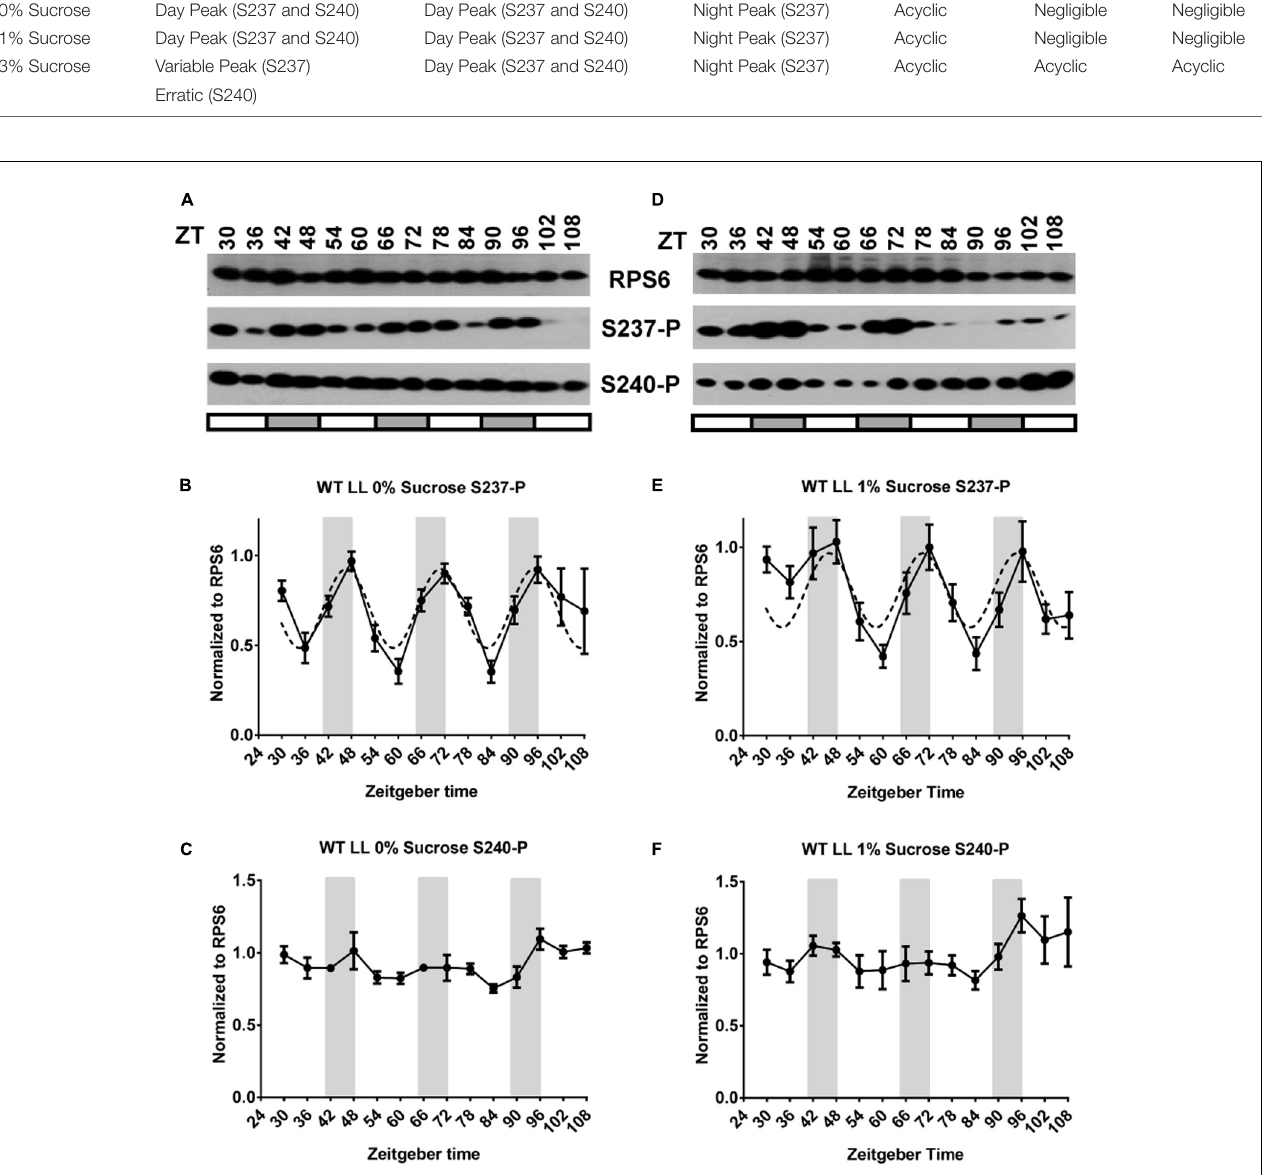
FIGURE 3 | The circadian clock drives cycles of RPS6 phosphorylation with a peak during the night. Seedlings of wild-type Arabidopsis were entrained in a light-dark cycle for 11 days, then shifted to continuous light for another four and a half days. Sampling began at ZT30 on the second day in continuous light. Seedlings were grown on medium lacking sucrose (A–C) or containing 1% sucrose (D–F) . (A,D) Representative immunoblots for S237-P and S240-P and total RPS6. (B,C,E,F) Immunoblot signals for S237-P and S240-P were quantified and normalized against total RPS6 signals from the same time point, followed by median-centering each data series and averaging of the multiple replicates. Error bars show the standard error of the mean from n = 4 replicates for 0% sucrose and n = 5 for 1% sucrose.